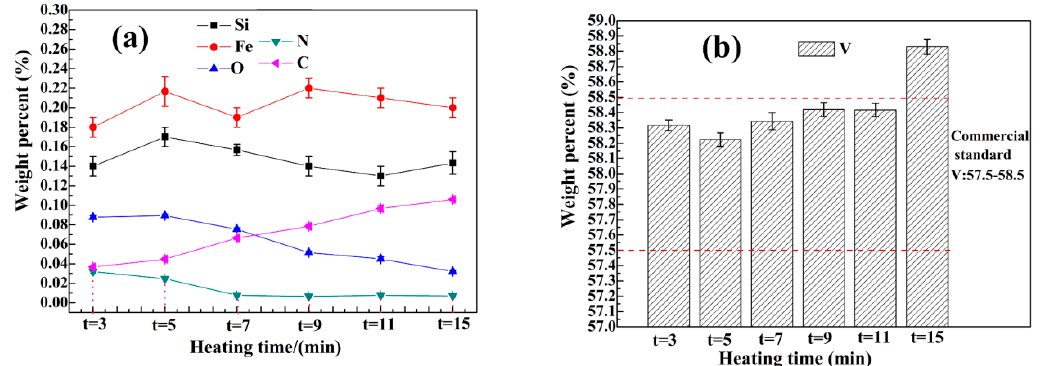
Table 3. The composition of the AlV55 alloy for commercial application (TS/T 579 ‐ 2014). Content of Element (%)